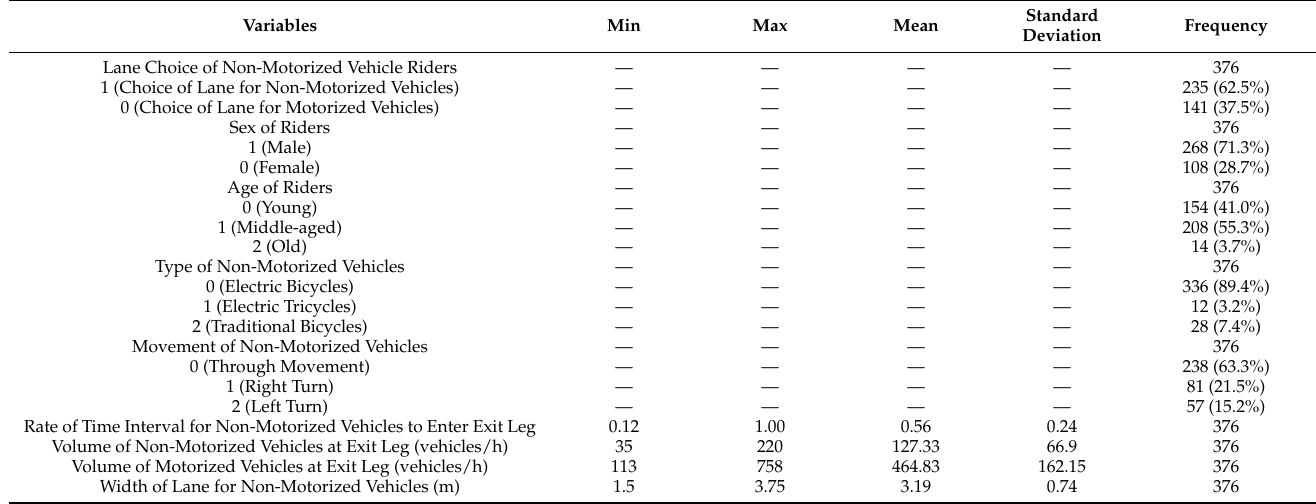
Table 2. Descriptive statistics of variables for model